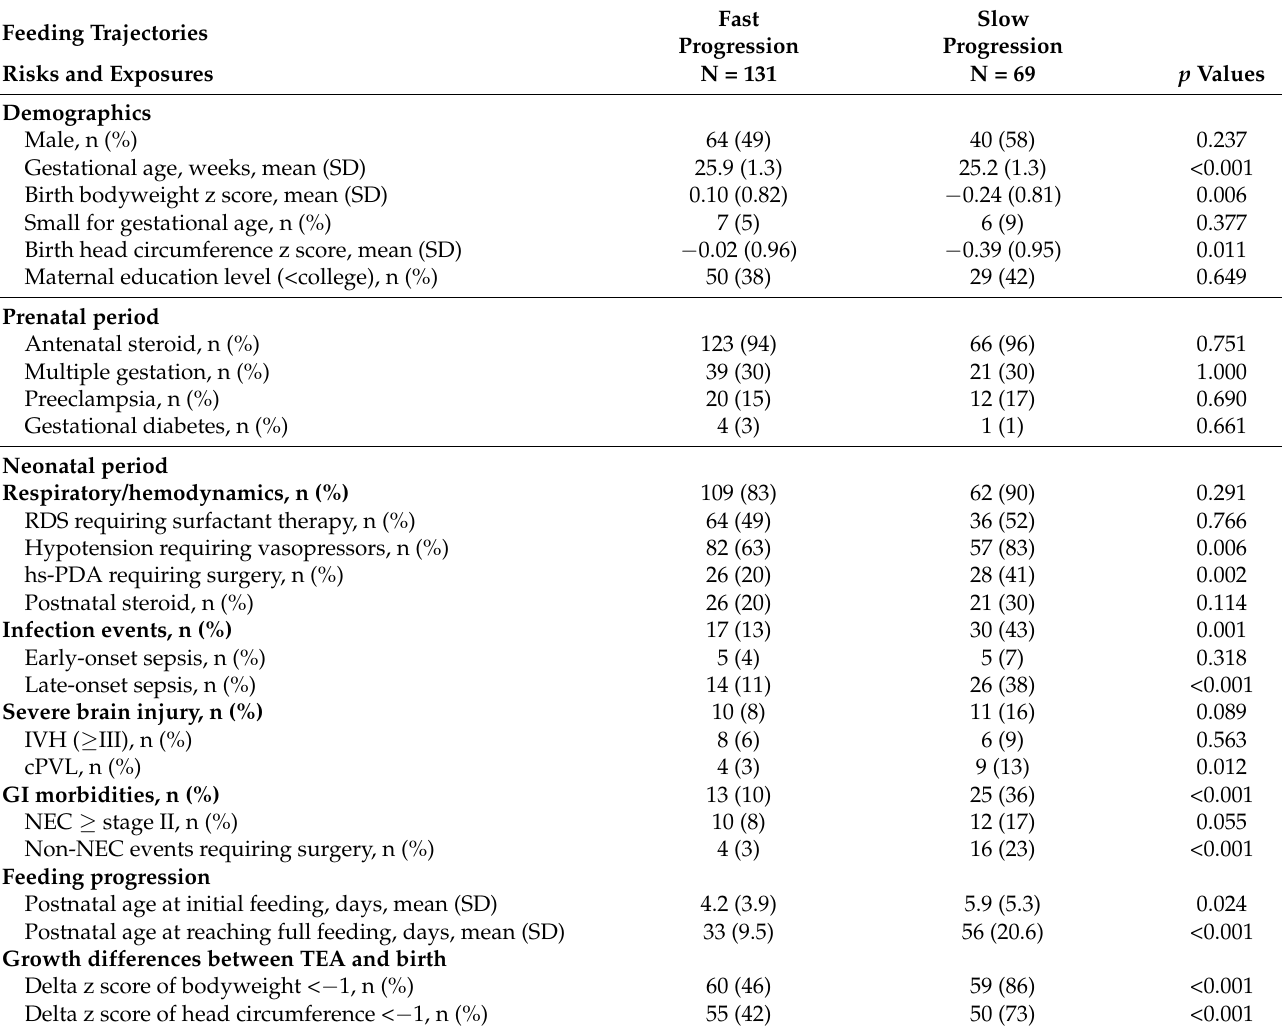
Table 1. Differences of demographics, prenatal and neonatal risks, and exposures between the fast progression and slow progression pattern groups in extremely preterm